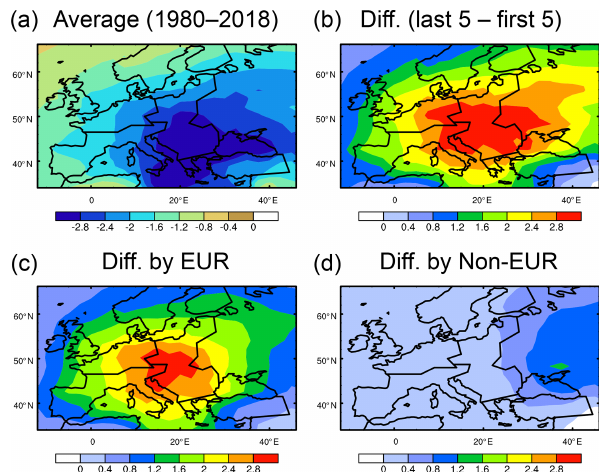
Figure 10. (a) Simulated annual mean DRF (in watts per square meter) of sulfate averaged over 1980–2018 and (b) the difference in sulfate DRF between 1980–1984 and 2014–2018. The contributions of European and non-European emissions to the difference are given in (c) and (d) ,